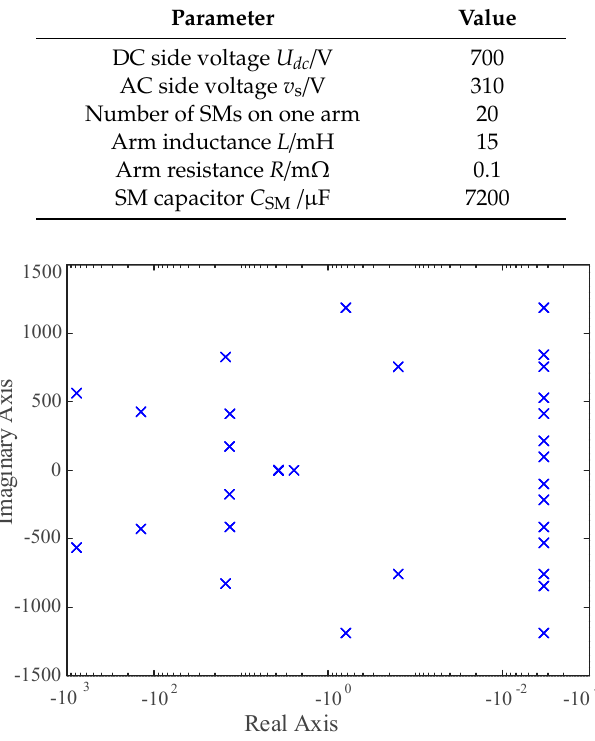
Figure 6. Calculated eigenvalues of the system matrix when k p 1 = 0.87, k i 1 = 10, k p 2 = 0.019, and k i 2 = 0.057.